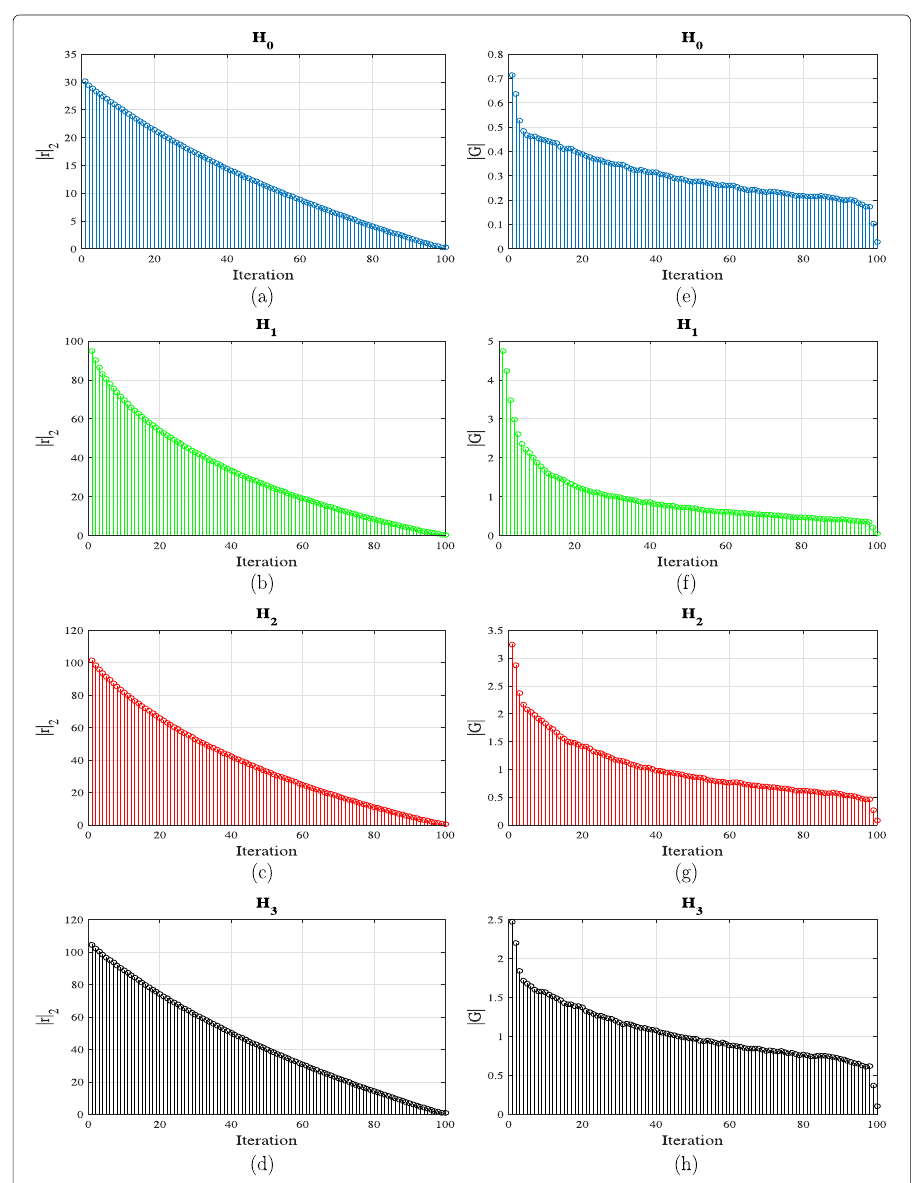
Fig. 2 The averages of { r } 2 versus sparse coding iteration for received signals under hypotheses H 0 , H 1 , H H 2 , and 3 are in ( a ), ( b ), ( c ), and ( d ), respectively, while the averages of are presented in ( e ), ( f ), ( g ), and ( h ), respectively